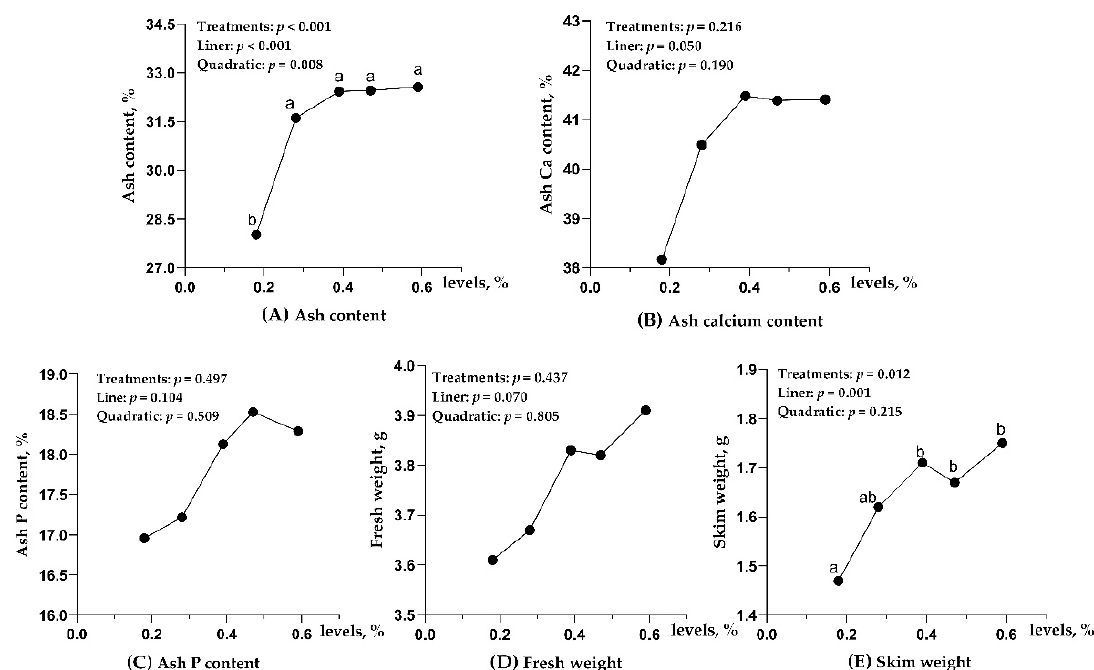
Figure 1. Effects of dietary non-phytate phosphorus (NPP) levels on the third phalanx variables in 28-day-old goslings. a,b Values within a row without common superscripts differ significantly ( p ≤ 0.05). P: phosphorus.